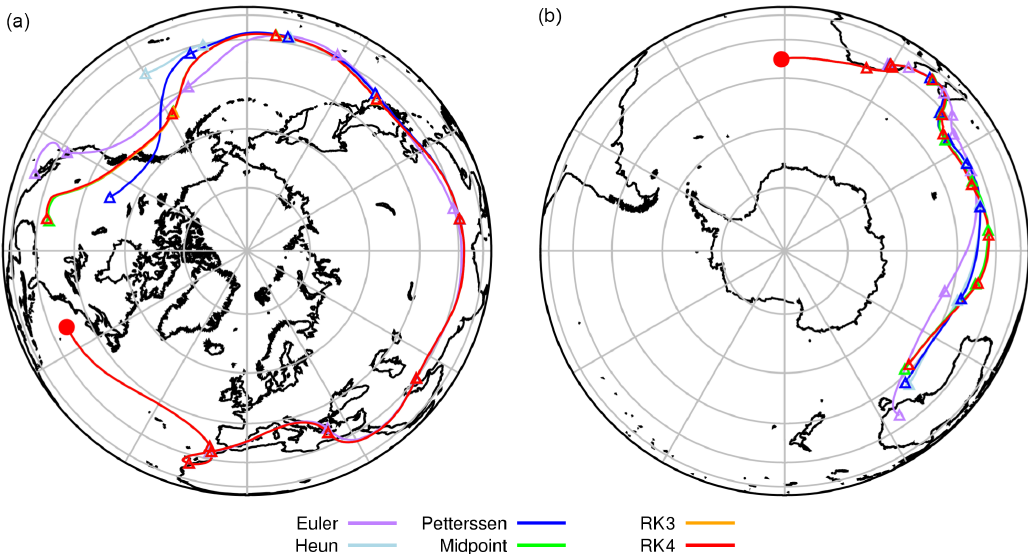
Figure 2. Examples of trajectory calculations using different numerical integration schemes. Circles mark the start positions of the trajecto- ries. Trajectories were launched at an altitude of 10.8km (a) and 9.7km (b) . The start time is 1 January 2014 (00:00UTC) for both. Triangles mark trajectory positions at 00:00UTC on each